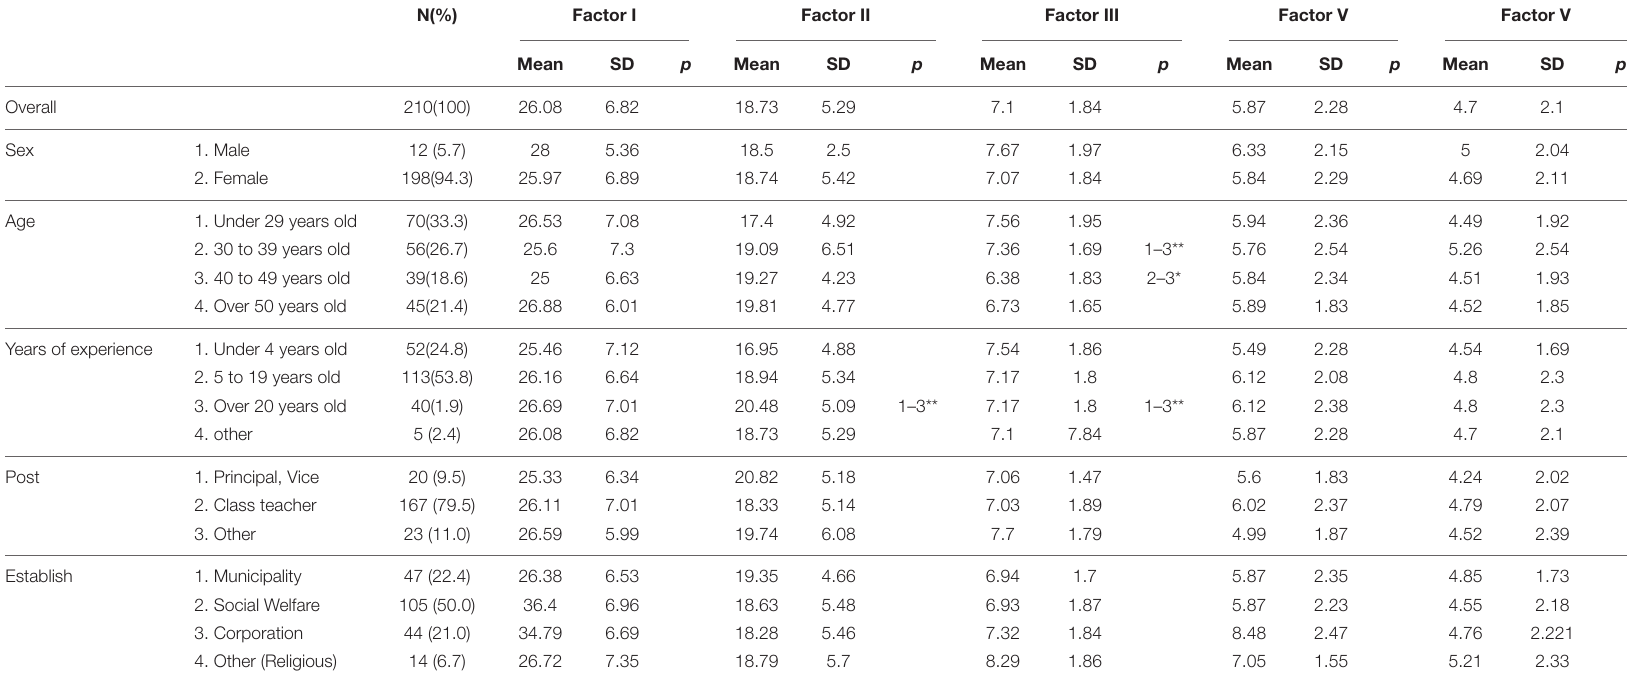
TABLE 5 | Relationship between subjects’ basic attributes and the SSIE